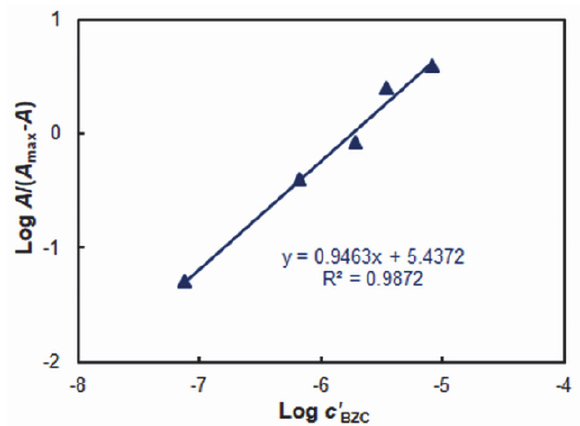
Figure 8. Determination of the BZC-to-Co molar ratio by the mo- bile equilibrium method.